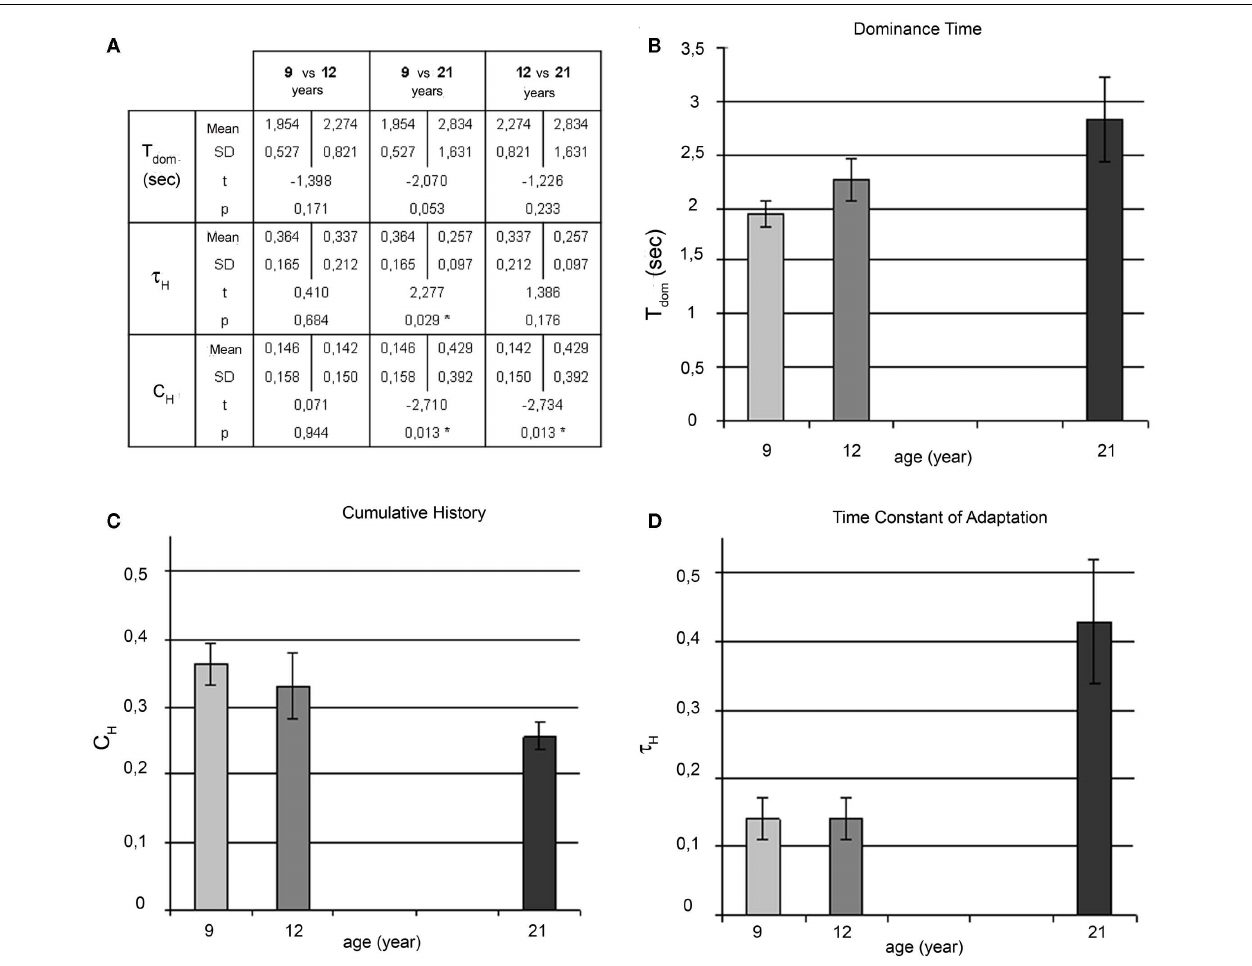
FIGURE 3 | Results. (A) Means, SDs, t -, and p -Values for each variable. T dom is mean dominance time; Coefficient of correlation with cumulative history c H is a measure of history dependence; Characteristic time-constant τ H indicates